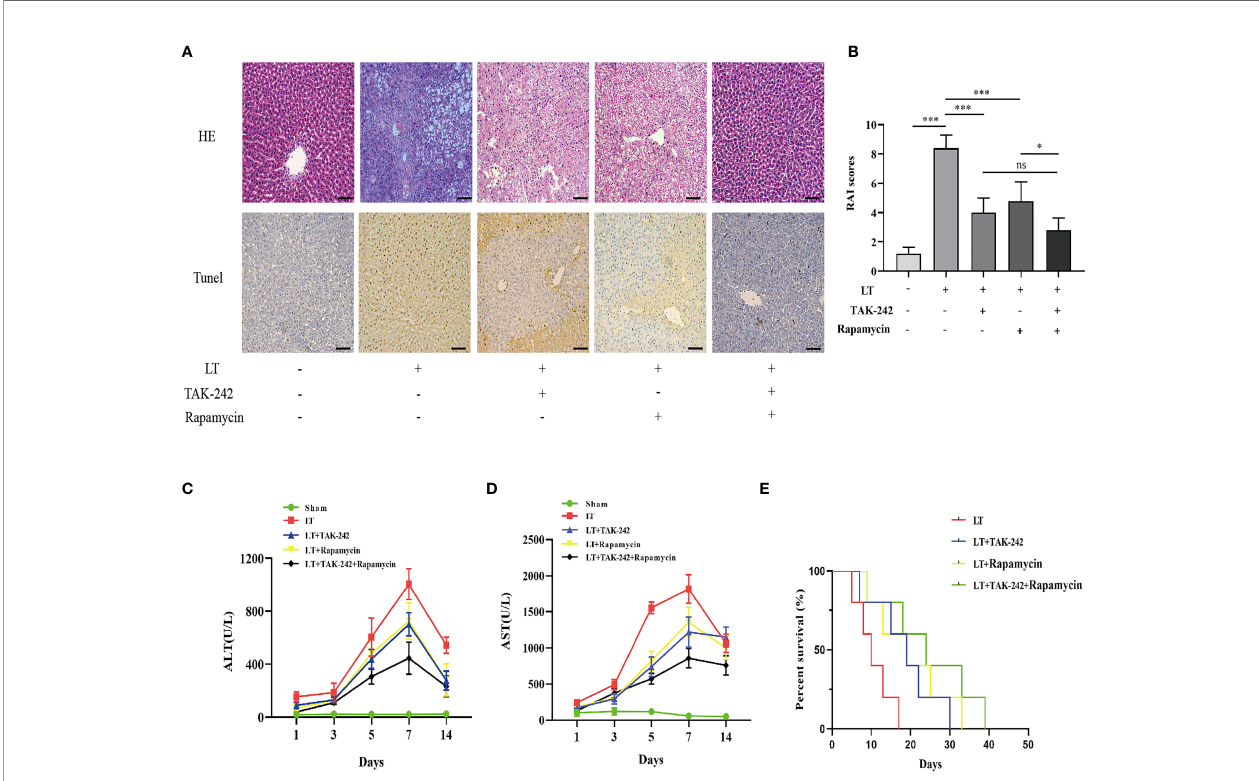
FIGURE 9 | Effects of co-treatment of TAK-242 and rapamycin on AR following liver transplantation in rats. (A) Pathological changes in the liver and hepatic apoptosis following co-treatment with TAK-242 and rapamycin during AR (magni fi cation, ×200; scale bar = 100 m m). (B) RAI was classi fi ed based on Banff patterns. (C, D) Serum levels of ALT and AST on days 1, 3, 5, 7, and 14 after liver transplantation. (E) Survival rate of rats. n = 6 for each group. Statistical differences among groups were assessed by one-way ANOVA. ns P > 0.05, * P < 0.05, *** P < 0.001.